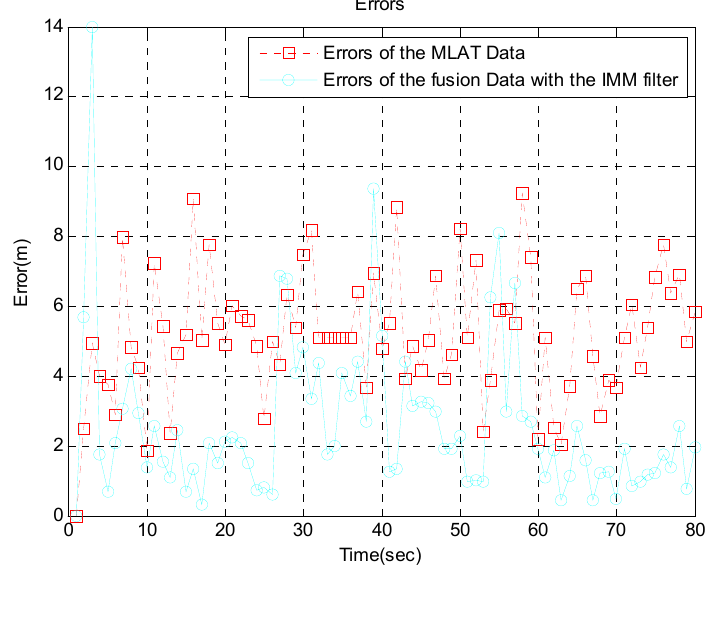
Figure 6. Errors between MLAT data and fusion data with the IMM filter near the